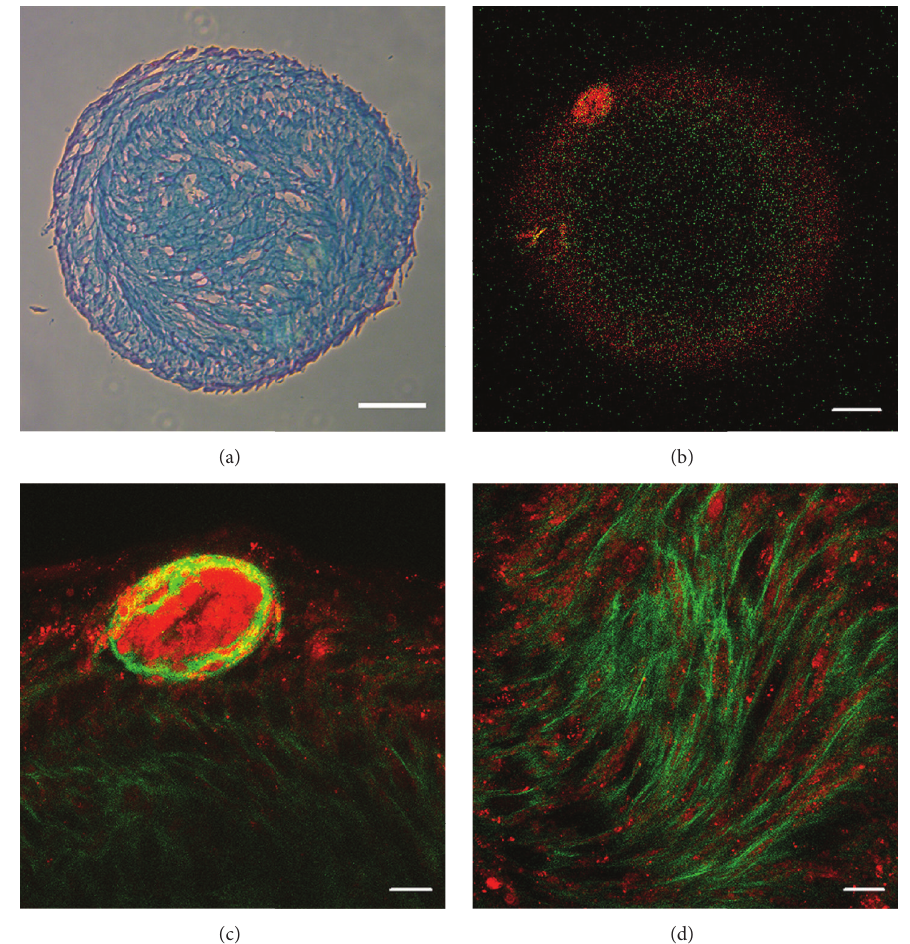
Figure 5: TPM and SHG imaging of WJ-MSCs chondrogenic differentiation. (a) Alcian Blue staining of a chondrogenic pellet section, visualizing the nuclei (red) and chondrogenic matrix (blue), scale bar = 200 𝜇 m. (b–d) AF (red) and SHG (green) imaging of an intact chondrogenic pellet of ± 1mm diameter. (b) Chondrogenic pellet center, scale bar = 100 𝜇 m. (c) Cell and matrix nodule at the pellet border, scale bar = 20 𝜇 m. (d) Differentiated cells within their collagen rich matrix in the center of the pellet, scale bar = 20 𝜇 m. Representative images for 2 independent experiments are